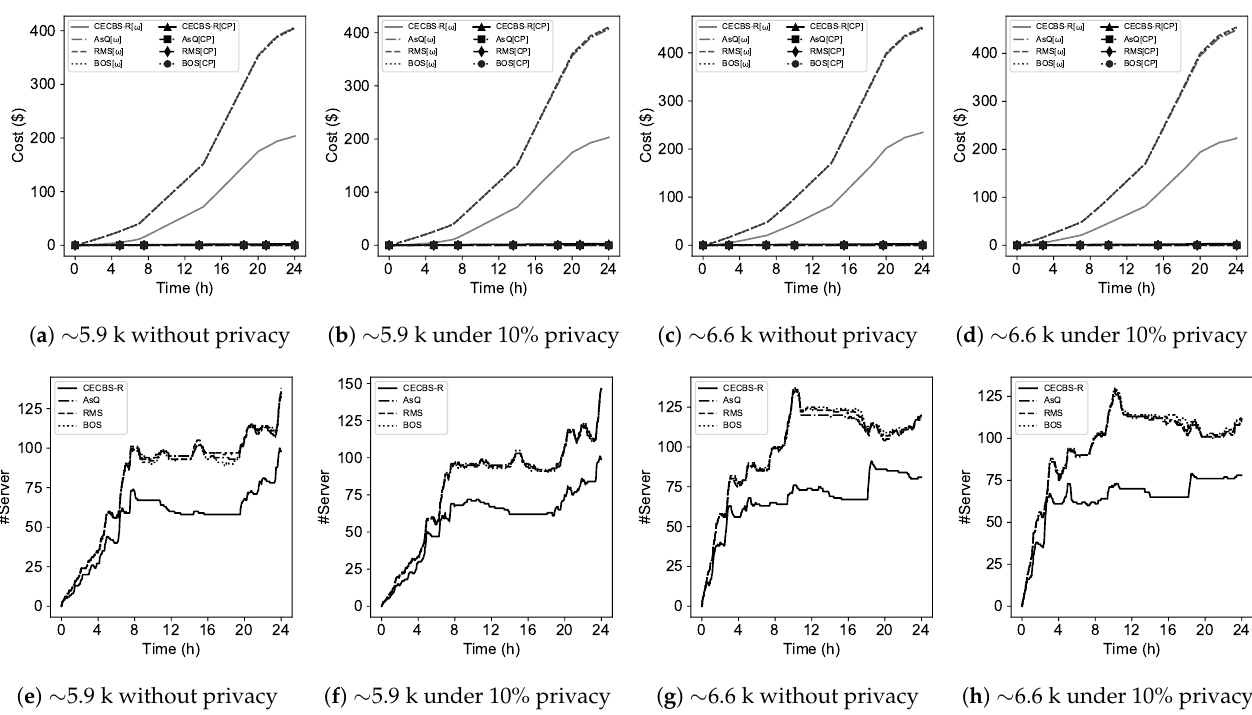
Figure 9. The accumulated edge ( ω ) and public cloud ( CP ) cost followed by the edge server usage for ∼ 5.9 k and ∼ 6.6 k jobs. Increasing the number of jobs in traces (Figure 10) changed the accumulated cost across the edge-cloud environment, as well as the edge server usage. The usage of public clouds also became more obvious, in particular, for Figure 10c,d. This shows that CECBS-R achieved the least total edge-cloud cost in comparison to the other algorithms through maintaining the execution workload within the edge. It is expected that it will result in higher server usage, which is clear in Figure 10e–h. Increasing the privacy ratio made the internal resources on the edge busier, therefore, it would be more cost efficient to schedule jobs on the resources across the edge-cloud environment. While CECBS-R barely had information about the accurate runtimes in comparison to the baseline algorithm, it could achieve lower edge cost (Figure 10a,b), which is also aligned with the server usage in Figure 10e,f. Furthermore, in Table 5(a), CECBS-R, on average, utilized more edge resources, leading to maintaining lower public cloud cost, which emphasizes